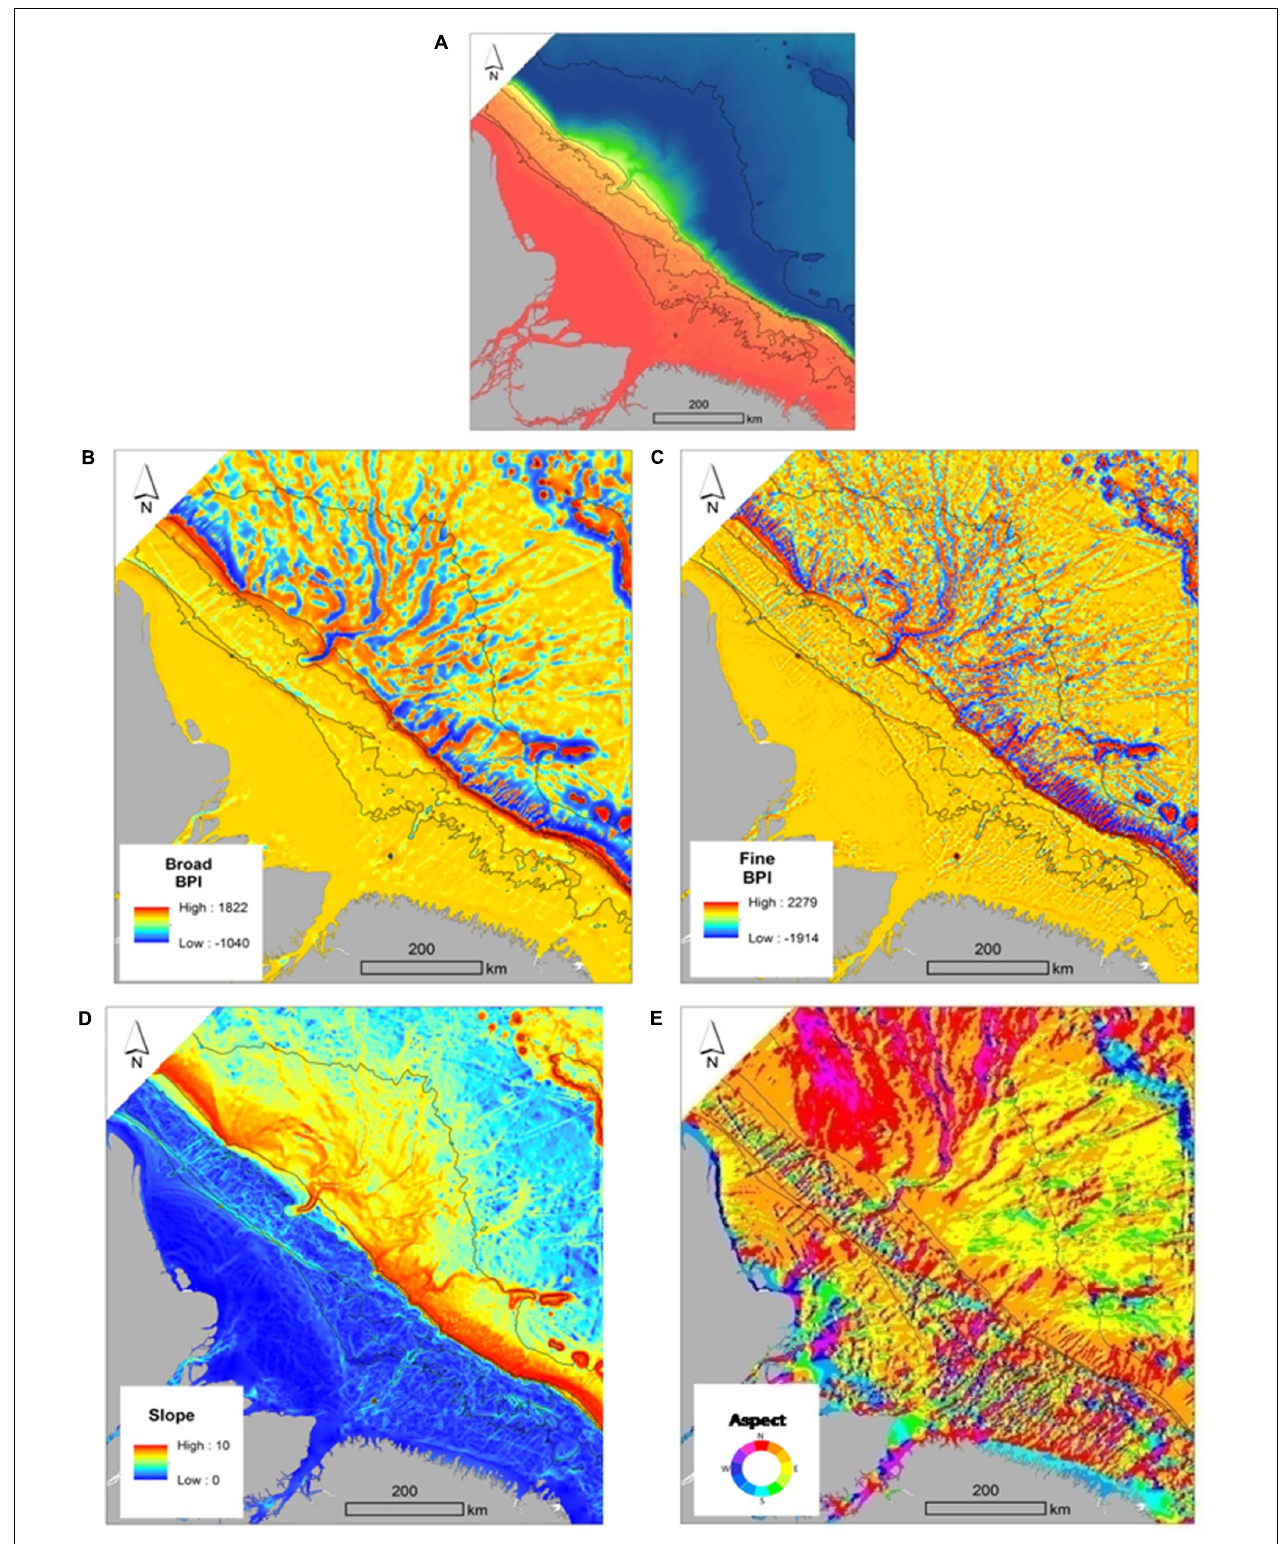
FIGURE 3 | Bathimetric grid (A) , Benthic Terrain Model results (B–D) and Aspect Grid (E) . Inserts (B) and (C) show the broad and fine BPI, respectively (standardized). Black lines refer to the 40-, 60-, 100-, and 3,500-m water depth isobaths, respectively.